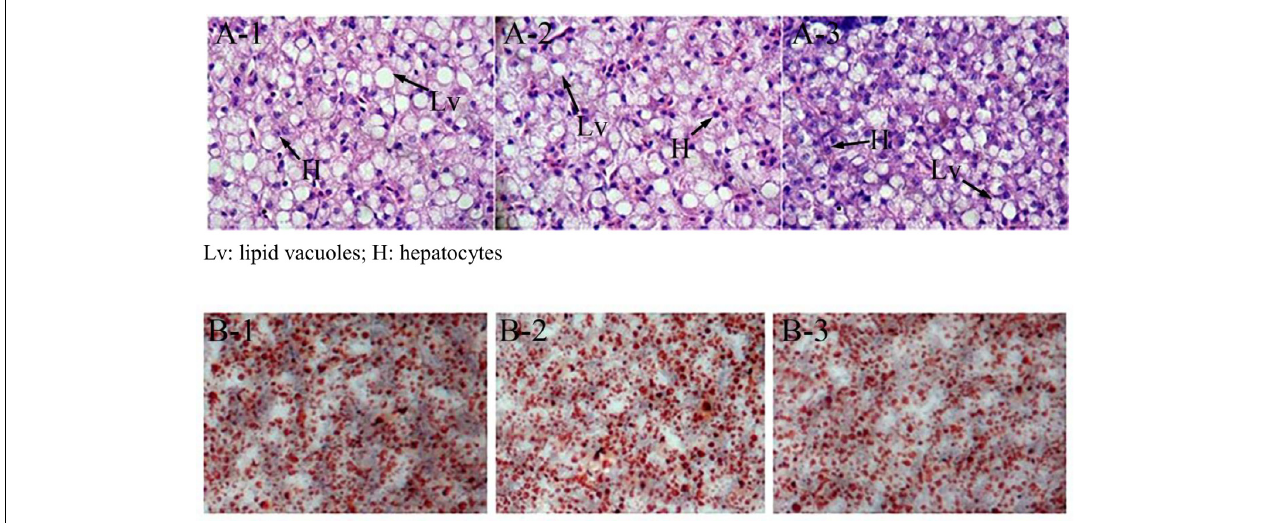
FIGURE 5 | Effect of miR-122 inhibition on fat deposition in liver tissue of GIFT fed a high-fat diet as determined by hematoxylin and eosin staining and oil red O staining. (A-1,B-1) Wild-type groups; (A-2,B-2) negative control groups; (A-3,B-3) miR-122 antagomir groups.